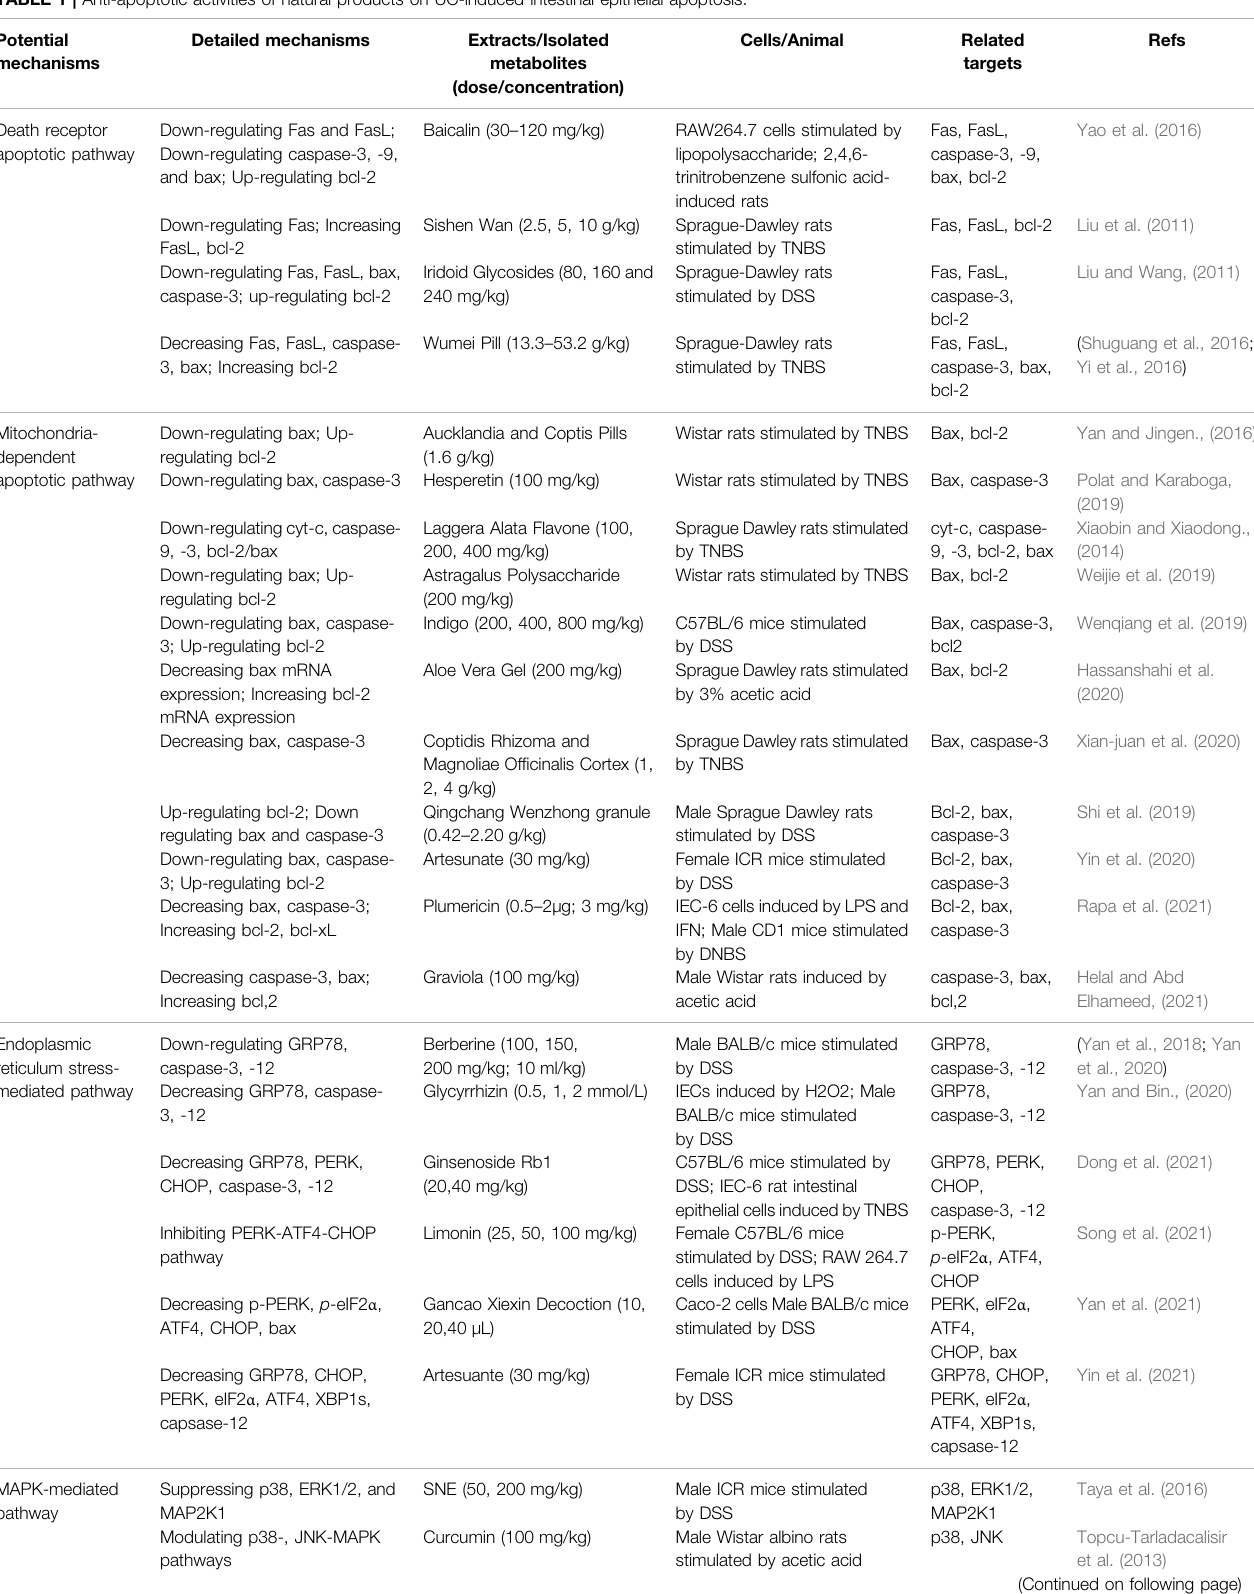
TABLE 1 | Anti-apoptotic activities of natural products on UC-induced intestinal epithelial apoptosis. Potential